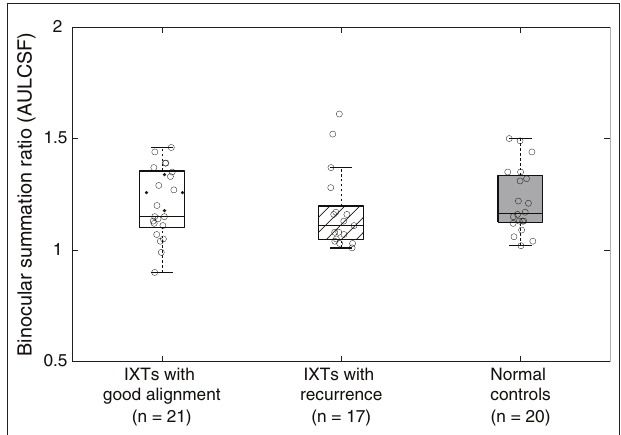
FIGURE 3 | Boxplots of binocular summation ratio at different spatial frequencies. Binocular summation was evaluated as the ratio of contrast sensitivity of binocular vision to that of the dominant eye. Binocular summation ratio distribution among surgically corrected IXT patients with recurrence, with good alignment and normal controls at different spatial frequencies. The box is drawn from the lower to the upper quartile. The horizontal line in the middle indicates the median. The lowest point represents the minimum of the dataset and the highest point represents the maximum of the dataset.